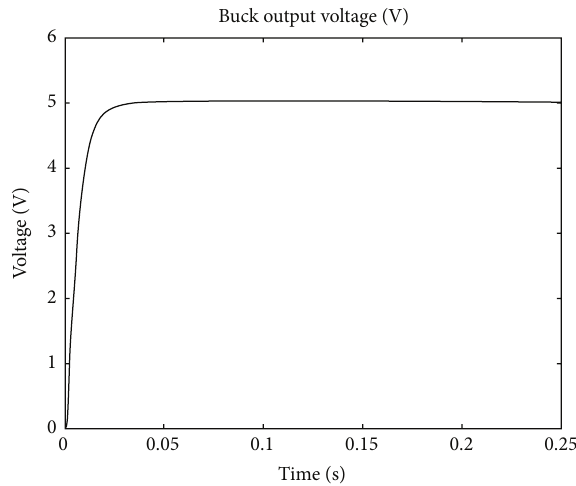
Figure 20: Output voltage of DC/DC converter for a step change in insolation from 900 (W/m 2 ) to 600 (W/m 2 ) in 30 ∘ C.